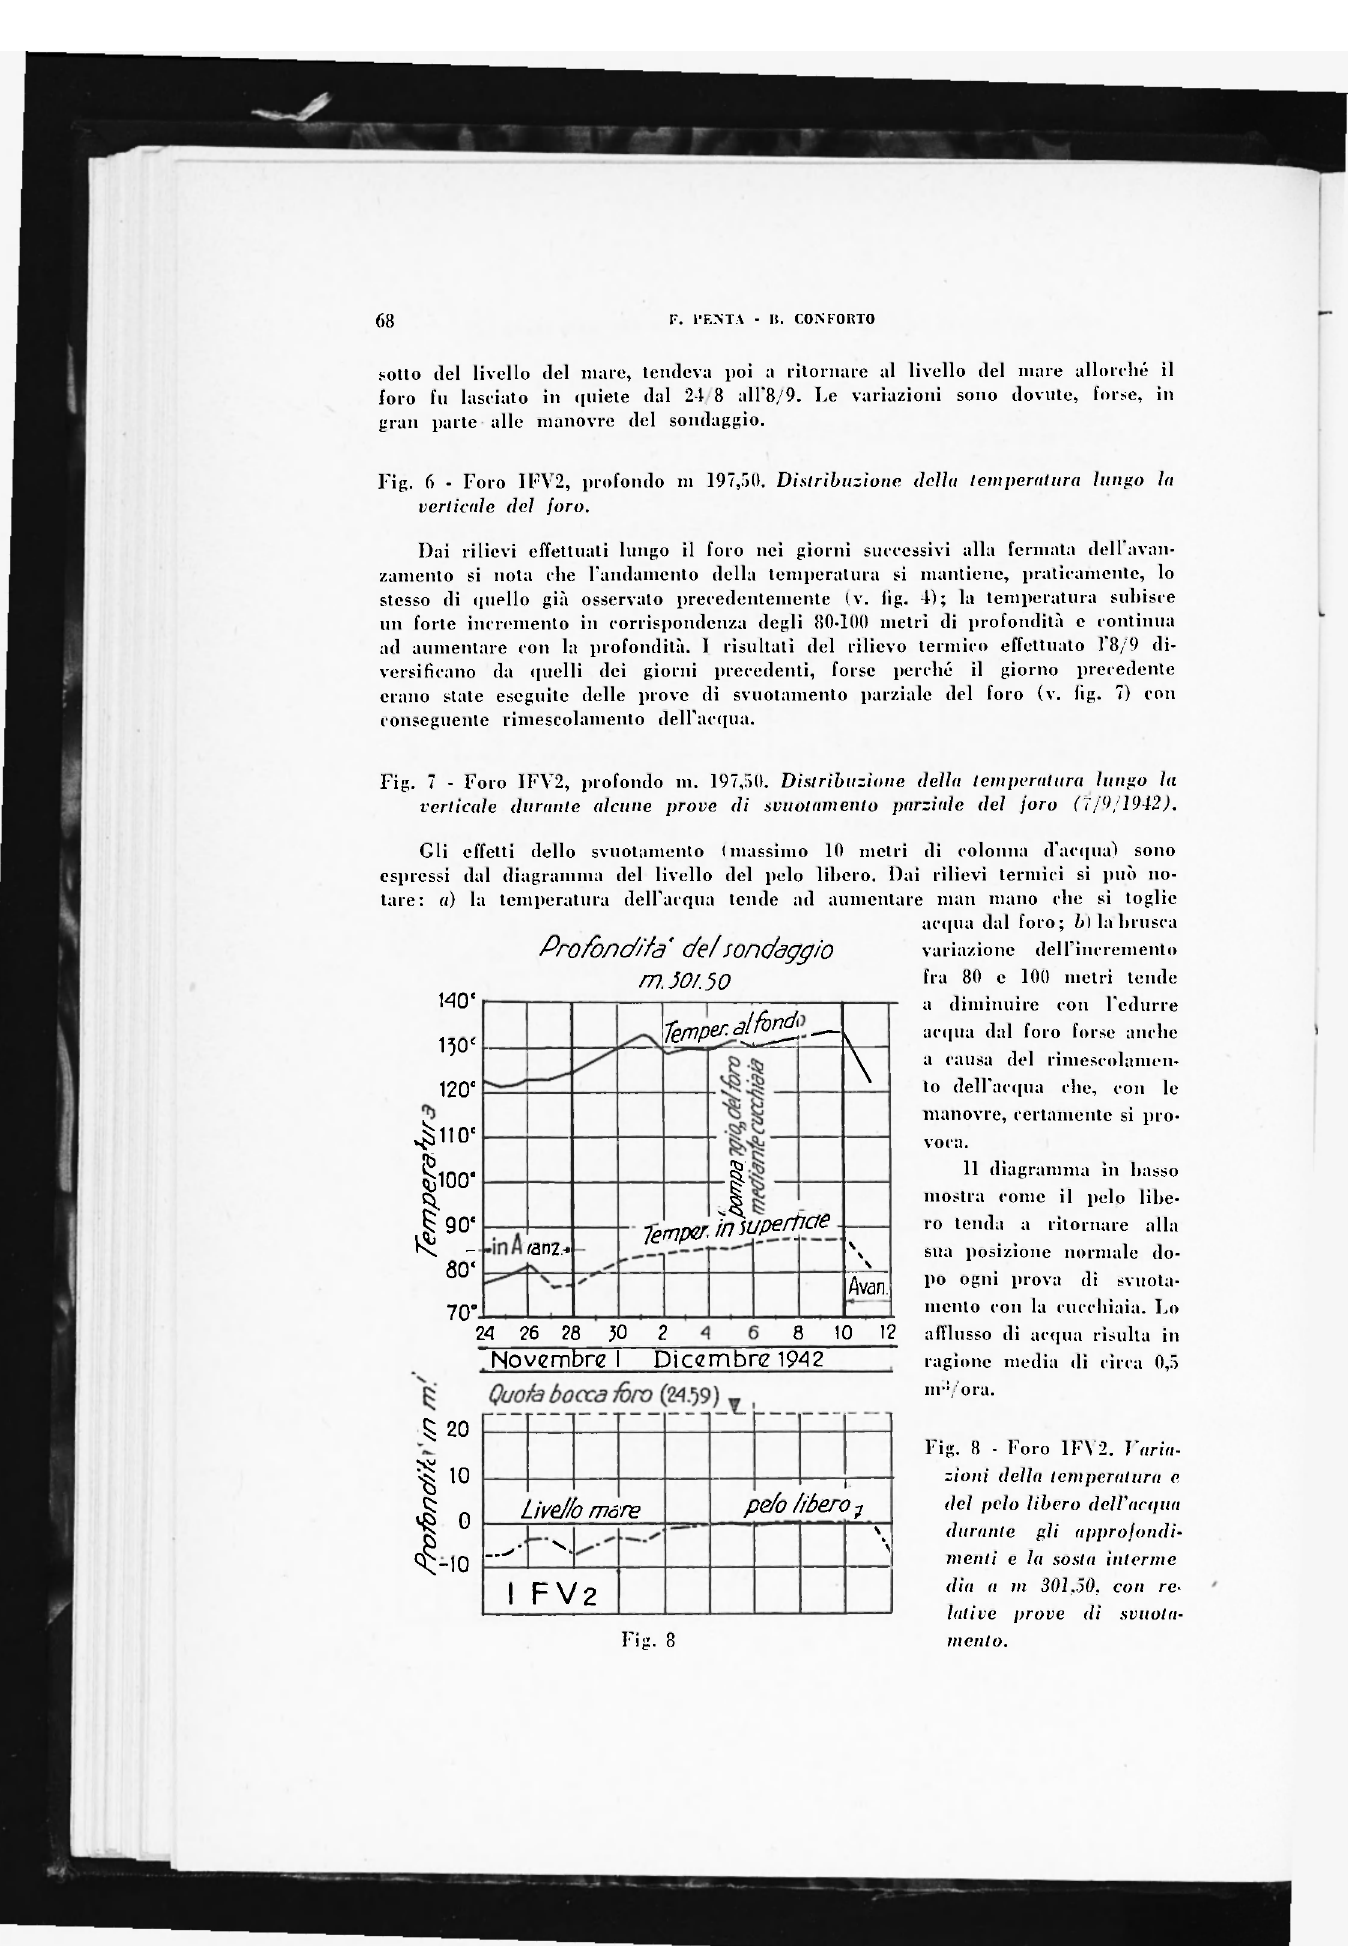
Fig. 7 - Foro IFV2, profondo m. 197,50. Distribuzione della temperatura lungo la verticale durante alcune prove di svuotamento parziale del joro